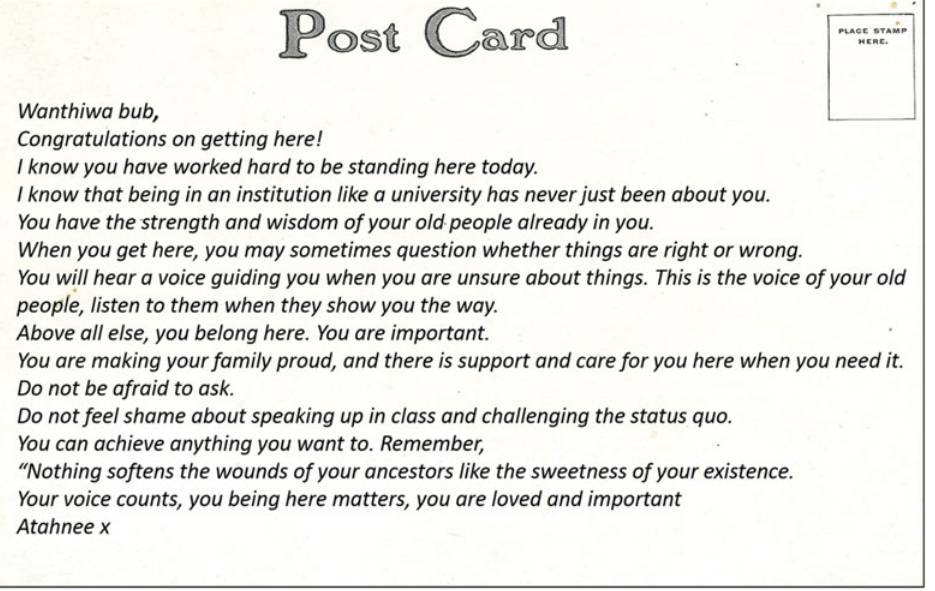
(Colour online) Atahnee